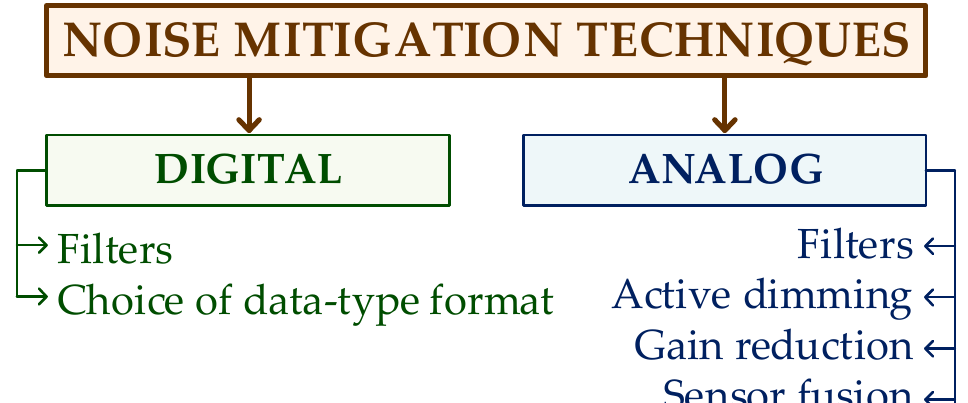
Figure 1. Noise mitigation techniques.